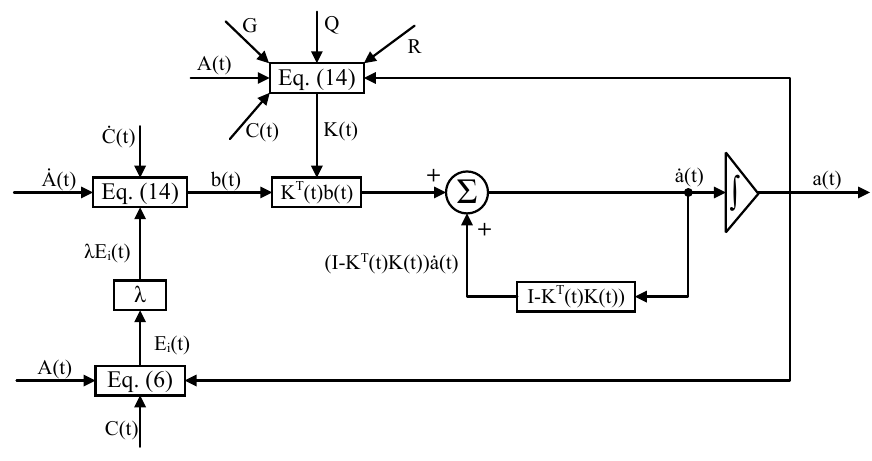
Figure 1. Block diagram of the ZNNFRDP model for real-time solution of the time-varying pseudoin- verse of matrix A ( t )